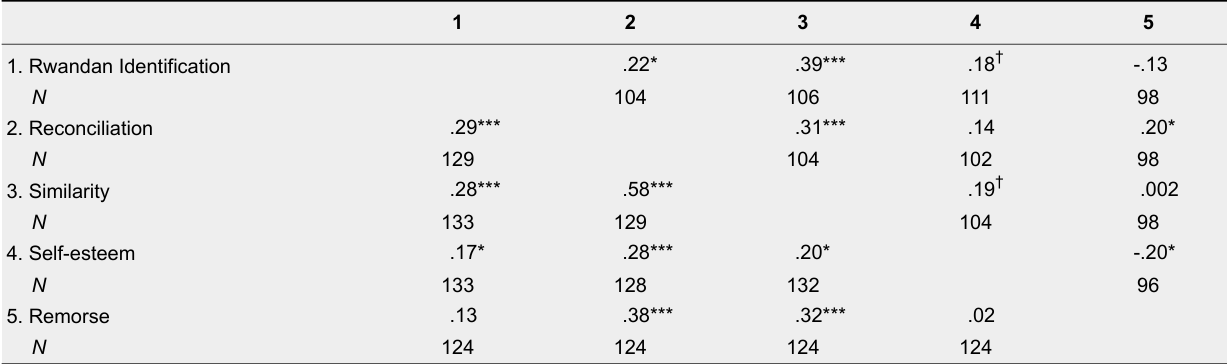
Pearson Bivariate Correlations between Main Variables of Interest among Survivors (Above Diagonal) and Non-Victims (Below Diagonal)